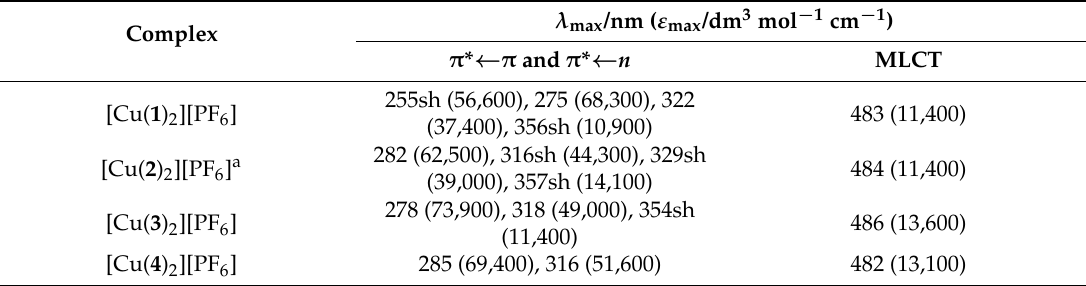
Figure 3. Solution absorption spectra of the homoleptic copper(I) complexes (CH 2 Cl 2 , 1 × 10 − 5 mol dm − 3 ). Table 1. Absorption maxima for homoleptic copper(I) complexes (CH 2 Cl 2 , 5 × 10 − 5 mol dm − 3 ) a